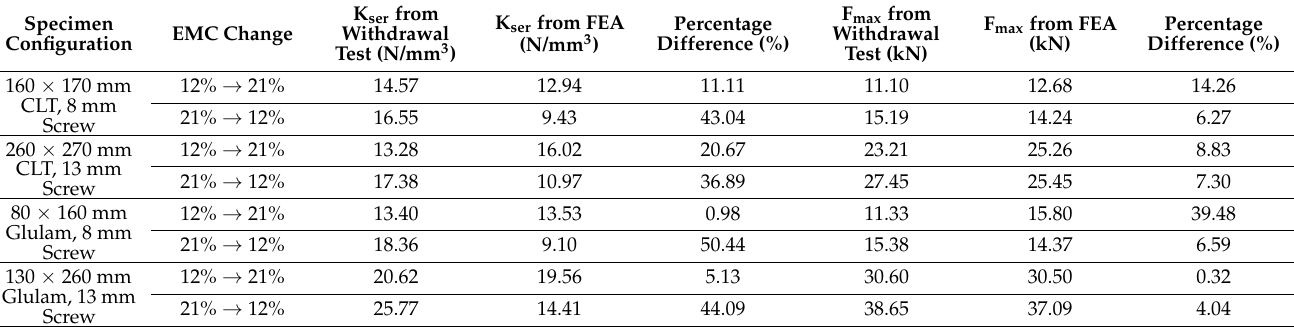
Table 23. Finite element model verification comparison.